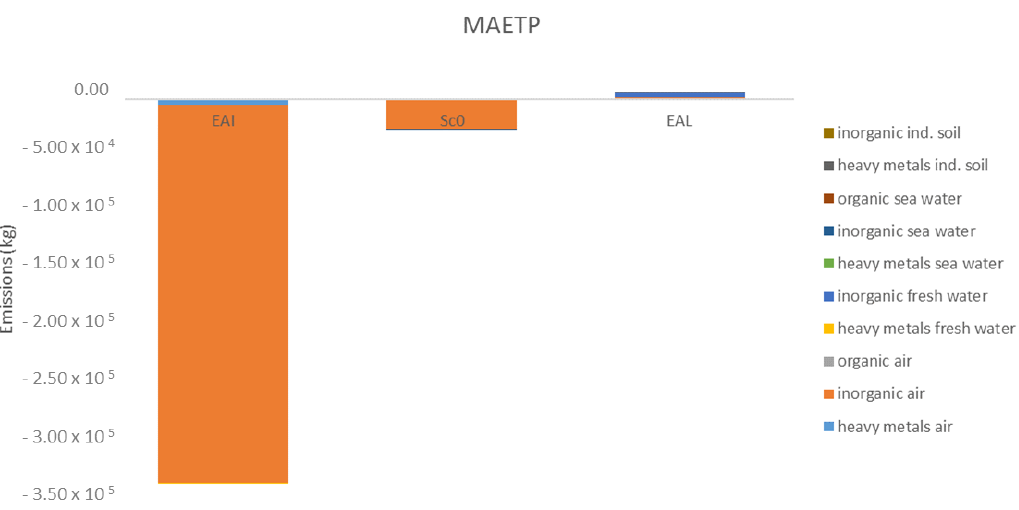
Figure 9. Marine water ecotoxicity comparison for the reference case (Sc0) among average scenarios. Results refer to one tonne of treated residues.